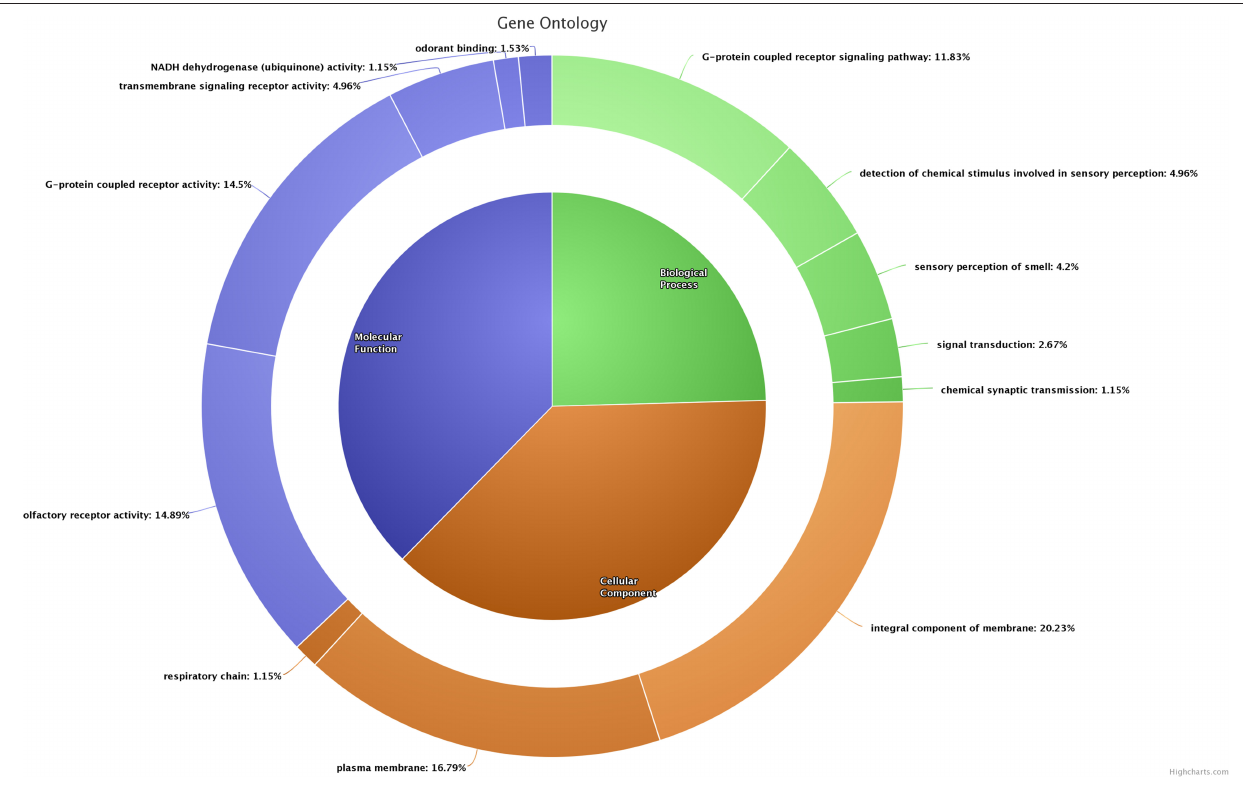
FIGURE 2 | Functional classification (biological process, cellular component, and molecular function) of dysregulated transcripts based on gene ontology.